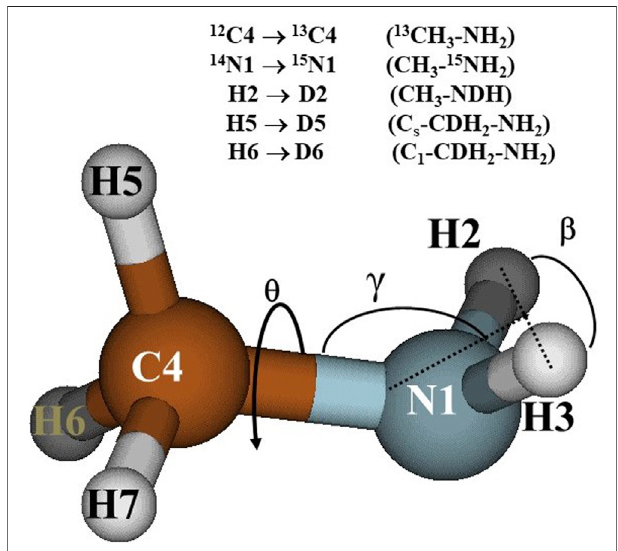
FIGURE 1 | Methylamine equilibrium